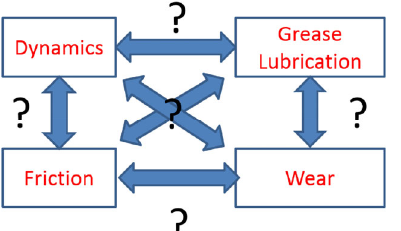
Fig. 16 The relationship between various components of a mechanism requires further study. After several decades of research there is no governing principle owing to the sheer complexity of the phenomenon